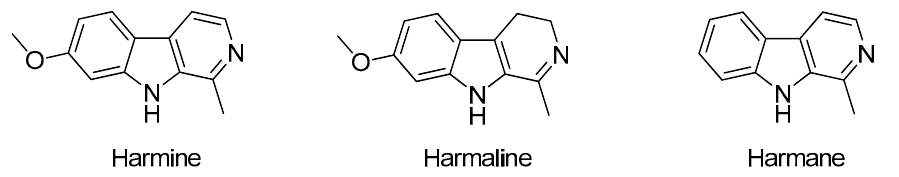
Figure 1. Structure of the major β -carboline alkaloids of P. harmala .